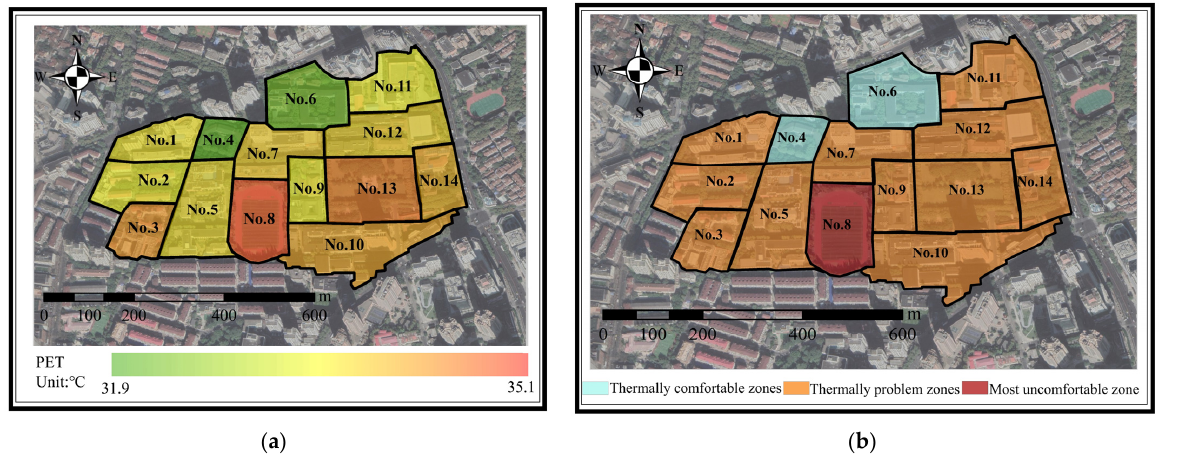
Figure 11. ( a ) Spatial distribution map of average PET across the whole university campus. ( b ) Ther- mal problem map across the whole university campus. mal problem map across the whole university